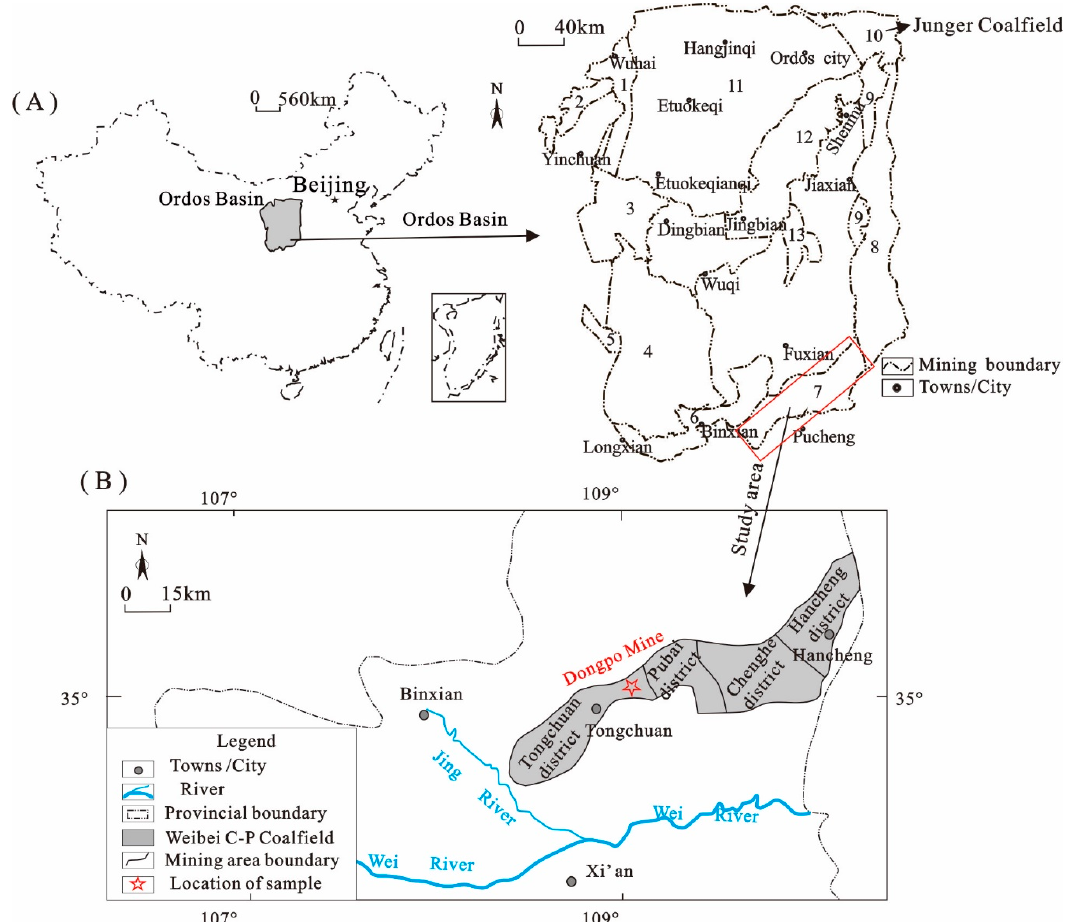
Figure 1. Locations of the ( A ) Ordos Basin and ( B ) Dongpo Mine modified after [35]. 1—Zhuozishan